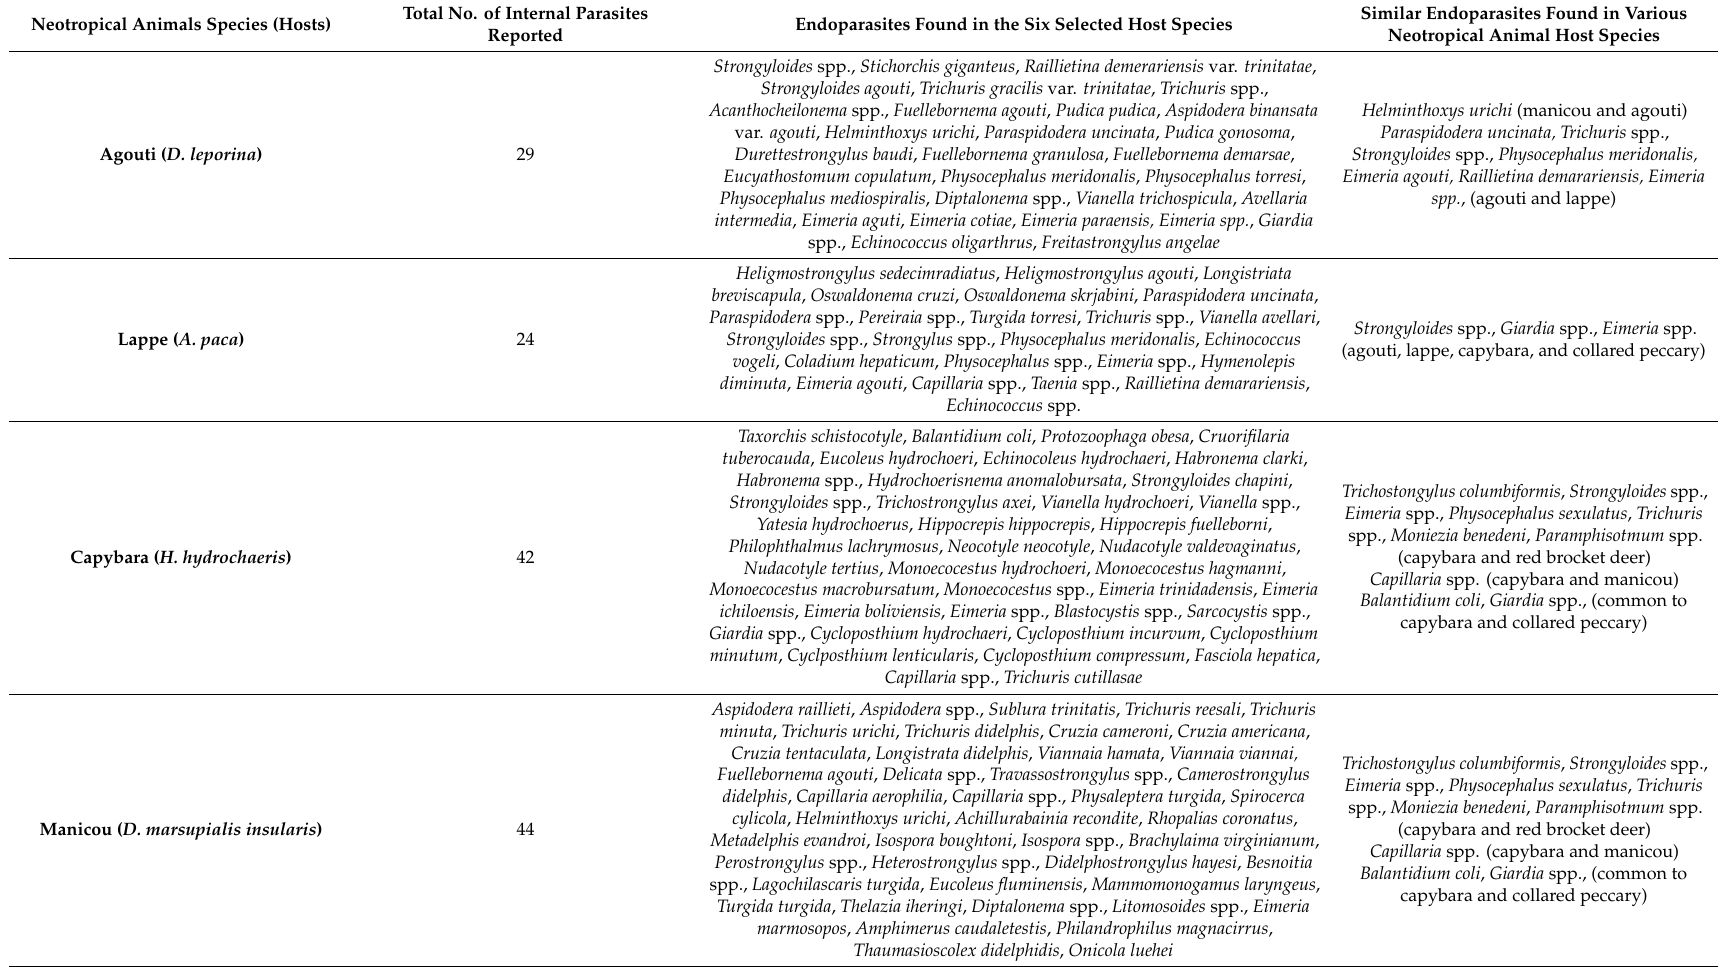
Table 7. Endoparasites found in selected non-domesticated neotropical